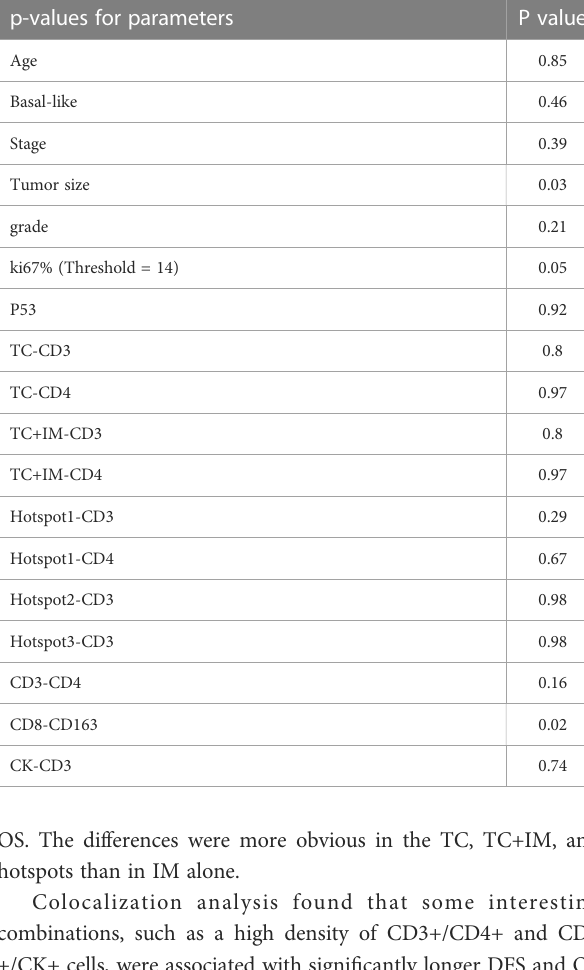
TABLE 5 The multivariate survival analysis with DFS of all parameters based on cell positive density for the group of all patients. p-values for parameters